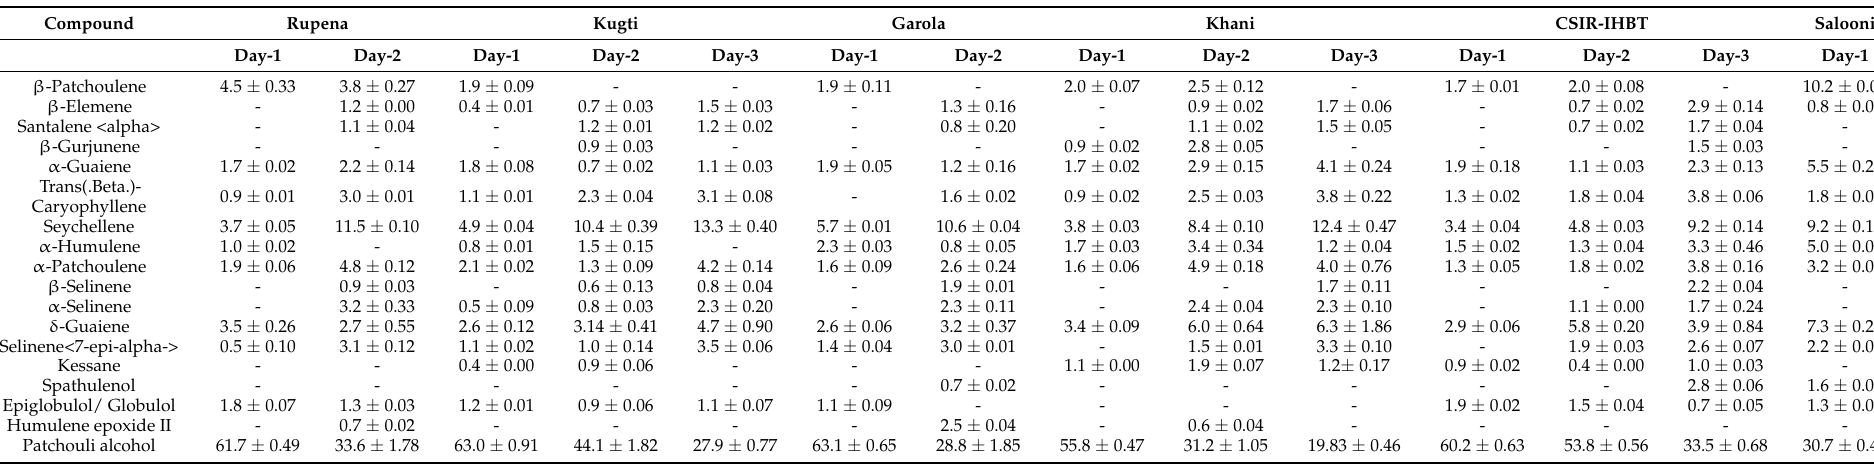
Table 1. The dynamic of composition of essential oil (%) in different populations of V. jatamansi, under repetitive distillation method.